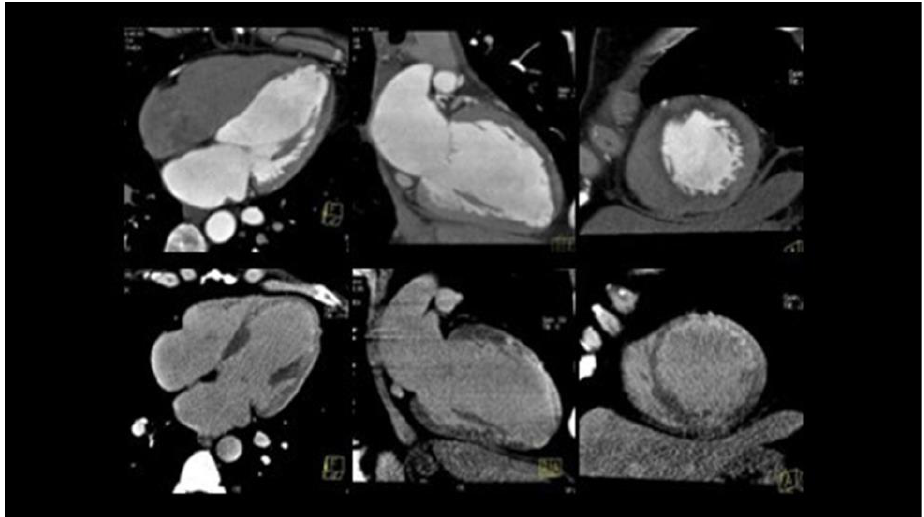
Figure 5. Cardiac CT of the same patient in Figure 4, showing contrast enhancement of the LV an- terior wall, secondary to myocardial